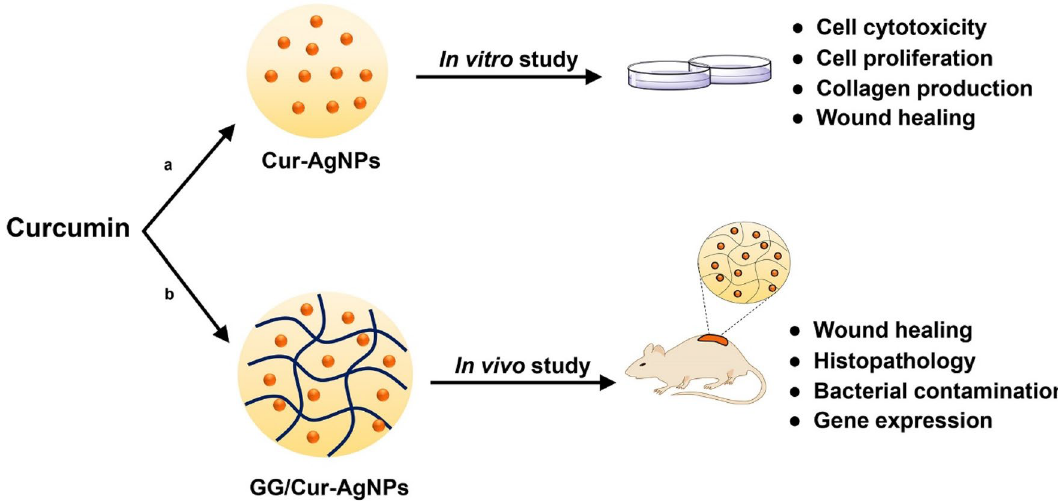
Figure 1. Overview of the study of enhanced wound healing using curcumin-silver nanoparticles (in vitro) and their hydrogel composites (in vivo). Curcumin is used as a surface-binding agent to stabilize silver nanoparticles (Cur-AgNPs) which are then composited into guar gum hydrogels (GG/Cur-AgNPs). ( a ) Cur-AgNPs were investigated for cell cytotoxicity, cell proliferation, collagen production, and wound healing in in vitro studies. ( b ) GG/Cur-AgNPs were studied for wound healing, histopathology, bacterial contamination, and gene expression in vivo on